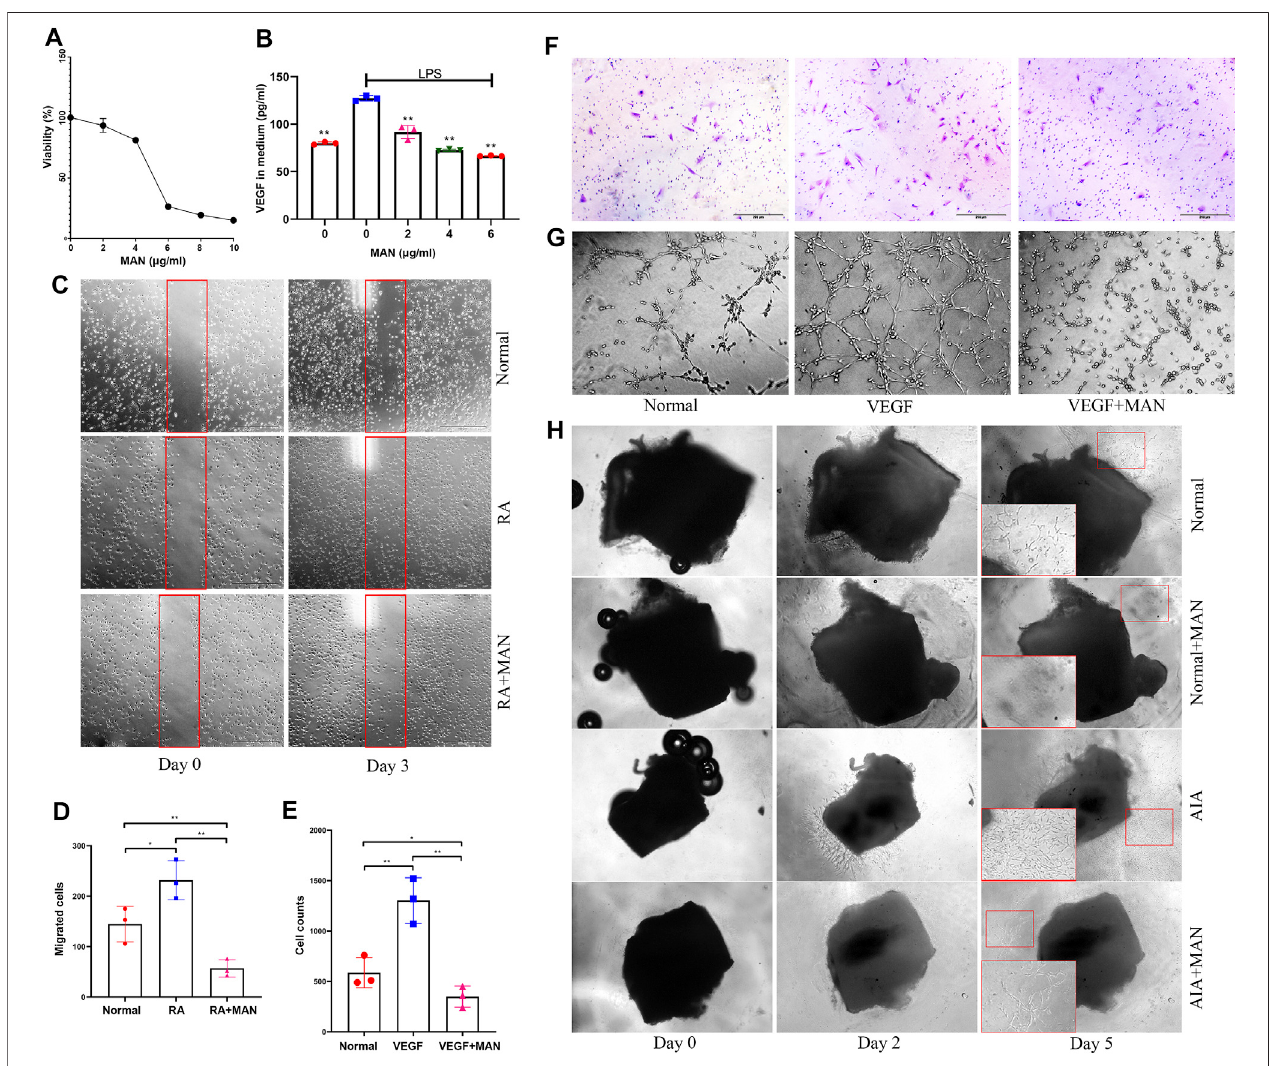
FIGURE3| MANinhibitedangiogenesispotentialsofendothelialcells invitro . (A) ,theeffectsofMANonHUVECsviability,assessedbyMTTassay( n (cid:2) 6); (B) ,MAN inhibited VEGF production in LPS-primed HUVECs in a concentration-dependent manner ( n (cid:2) 3); (C) , MAN inhibited the migration of RA serum-cultured HUVECs in scratchassay; (D) ,thequanti fi cationresultofassayC; (E) ,MANdecreasedthecountsofHUVECsin fi ltratedthroughtranswellintheexistenceofVEGF; (F) ,thein fi ltrated HUVECs was dyed with crystal violet in the replicate of assay E; (G) , MAN impaired the capacity of VEGF-primed HUVECs to form tubes in vitro ; (H) , suppressive effects of MAN on migration/growth of rat arterial ring-derived endothelial cells under both normal and AIA conditions. Statistical signi fi cances in image B: ** p < 0.01 compared with LPS-primed cells.